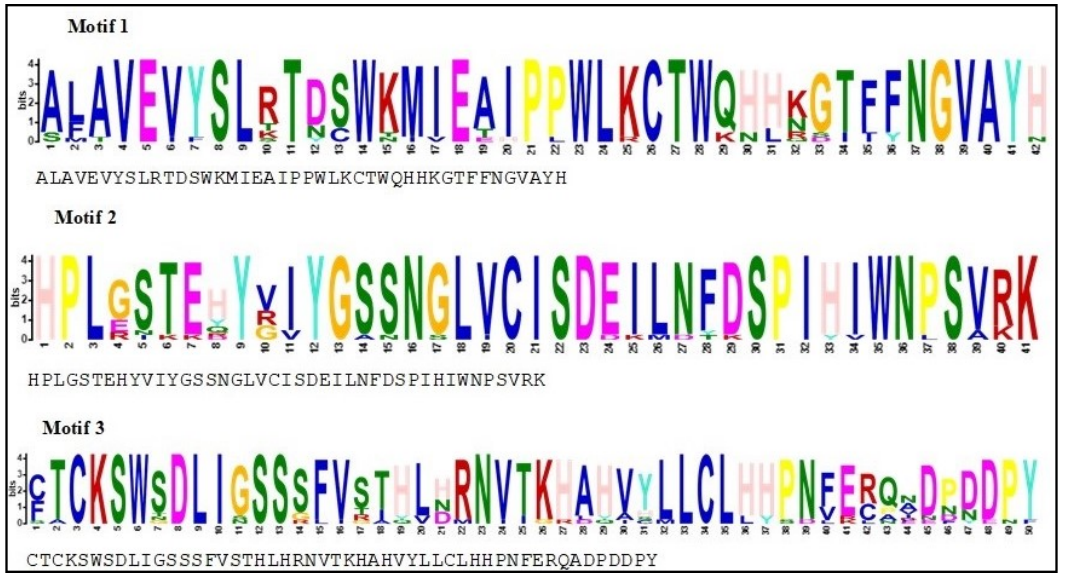
Figure 5. Summary sequence LOGO and regular expression of each motif shared by SFB proteins in Japanese apricot. At each location in the motif, the sequence logo features stacks of letters. The ‘information content’ of that place in the motif in bits is the whole height of the stack. The likelihood of the letter at that location multiplied by the overall information content of the stack determines the height of individual letters in a stack. The motif is described by the black letter below the sequence logo, which is a regular expression (RE). The RE includes all letters with observed frequencies greater than 0.2; less-frequent letters are not included.